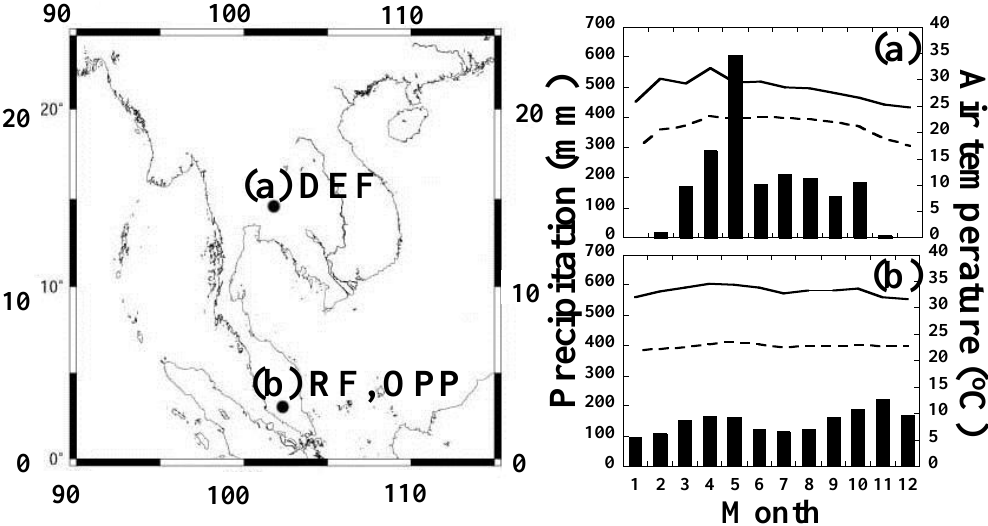
Fig. 1. Locations of the dry evergreen forest (DEF) in Thailand and the rainforest (RF) and the oil palm plantation (OPP) in Peninsular Malaysia. Climate data for (a) DEF (2001–2003, from the AsiaFlux Database) and (b) RF and OPP (1991–1997, from Manokaran et al., 2004). Solid and broken lines show the monthly means of daily maximum and minimum air temperatures, respectively; vertical bars show the monthly